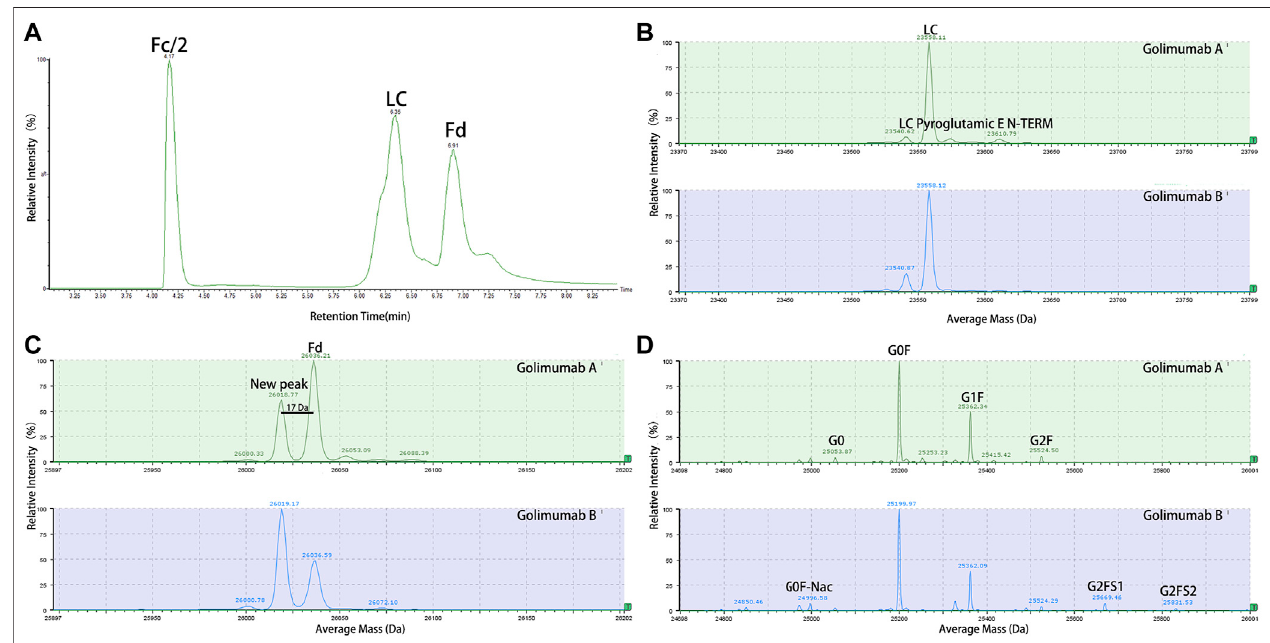
FIGURE 2 | Unexpected peak was detected in the Fd region of golimumab by the subunit-based MAM. Golimumab was digested by IdeS and reduced by TCEP and then analyzed by the subunit-based MAM (TIC). (A) Deconvoluted mass spectrum of the LC (B) , Fd (C) , and Fc/2 (D) of golimumab A and B.